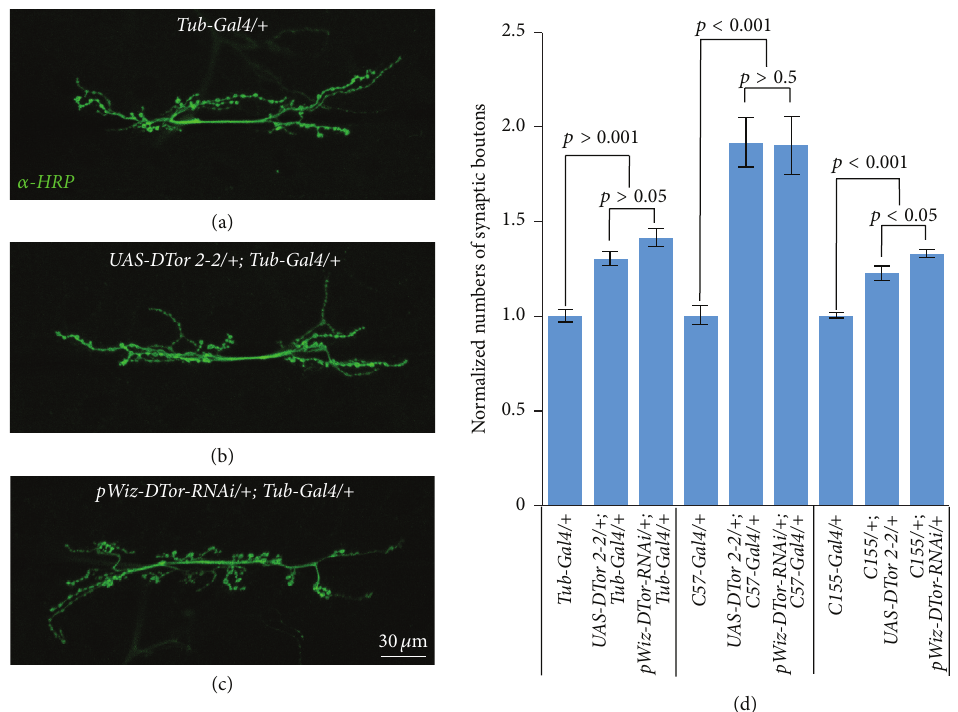
Figure 3: Altered NMJ structures in DTor mutants. (a–c) Representative NMJ morphologies from (a) control ( Tub-Gal4/+ ), (b) DTor-cDNA overexpression ( UAS-DTor 2-2/+; Tub-Gal4/+ ), and (c) DTor-RNAi expression ( pWiz-DTor-RNAi/+; Tub-Gal4/+ ) NMJs. (d) Quantification of the number of synaptic boutons when DTor-cDNA or DTor-RNAi were expressed ubiquitously (Tub-Gal4); postsynaptically, in the muscle (C57-Gal4); and presynaptically, pan-neuronally (C155-Gal4). Alteration of DTor proteins at pre- and/or postsynaptic terminals significantly increased the number of synaptic